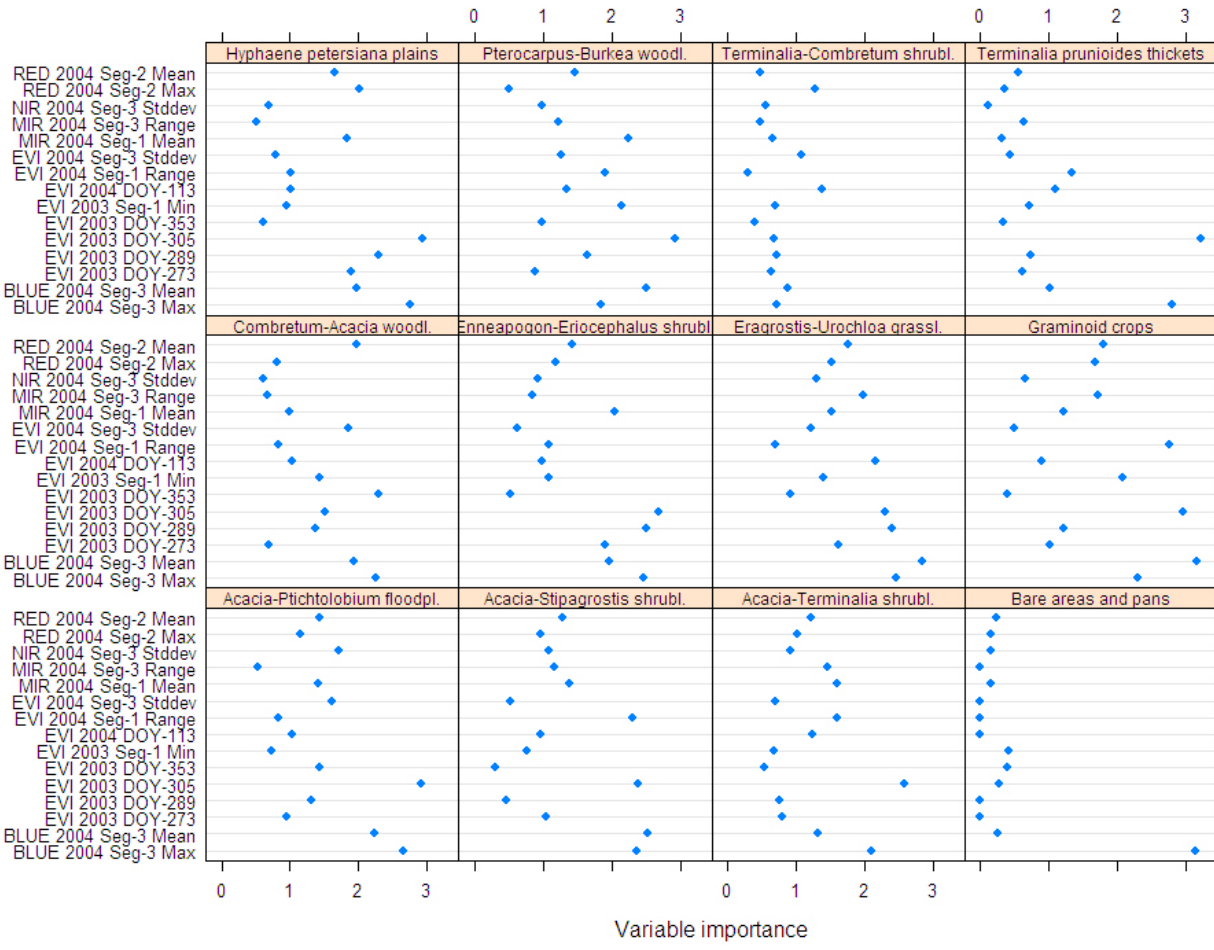
Figure 7. Variable importance visualizing the 15 top-ranked MODIS time series metrics for mapping Kalahari vegetation types based on the seasonal feature set 2003–2004 as decrease of OOB